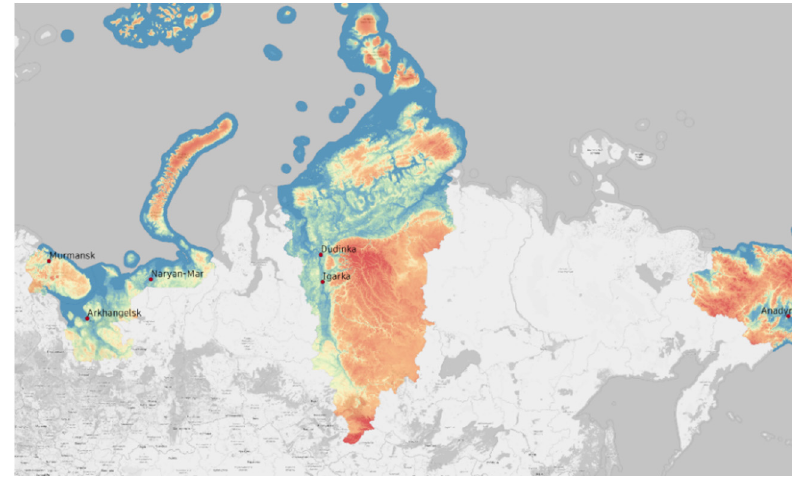
Figure 2. Topographic map of the Arctic zone of the Russian Federation.